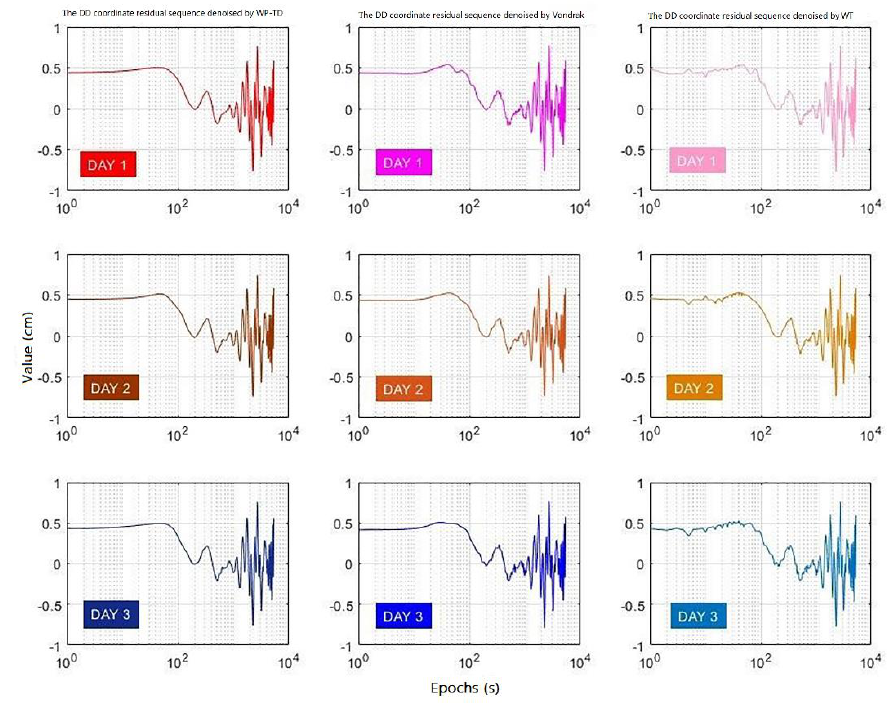
Figure 10. The DD coordinate residual sequences denoised by the three algorithms for three consecutive days.